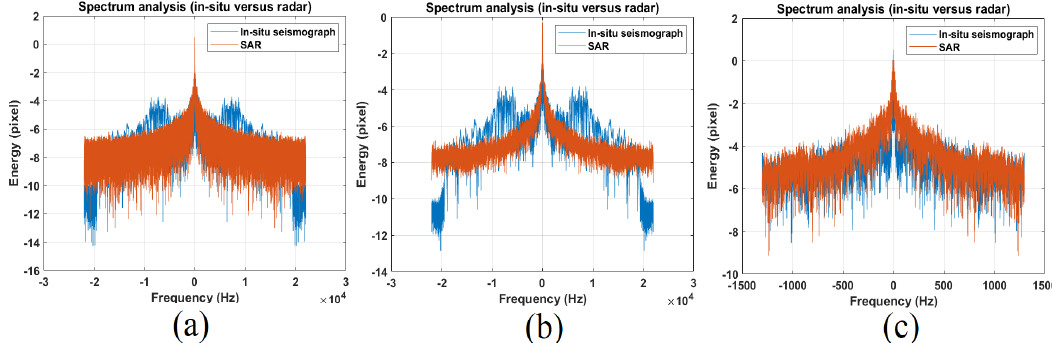
Figure 22. IV-VCRE seismograph station versus SAR synchronized signals spectrum. ( a ) unfiltered. ( b ) low-pass filtered. ( c ) 1 kHz filtered